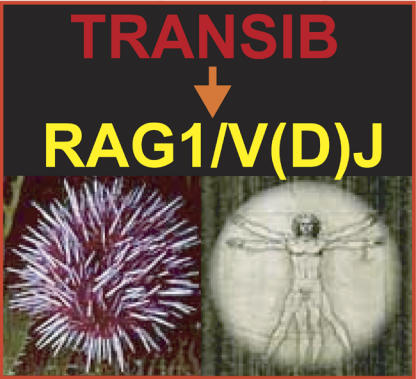
A gene involved in V(D)J recombination—which allows immune cells to recognize an unlimited number of antigens by reshuffling immune receptor gene segments—evolved from an ancient gene-transposing enzyme